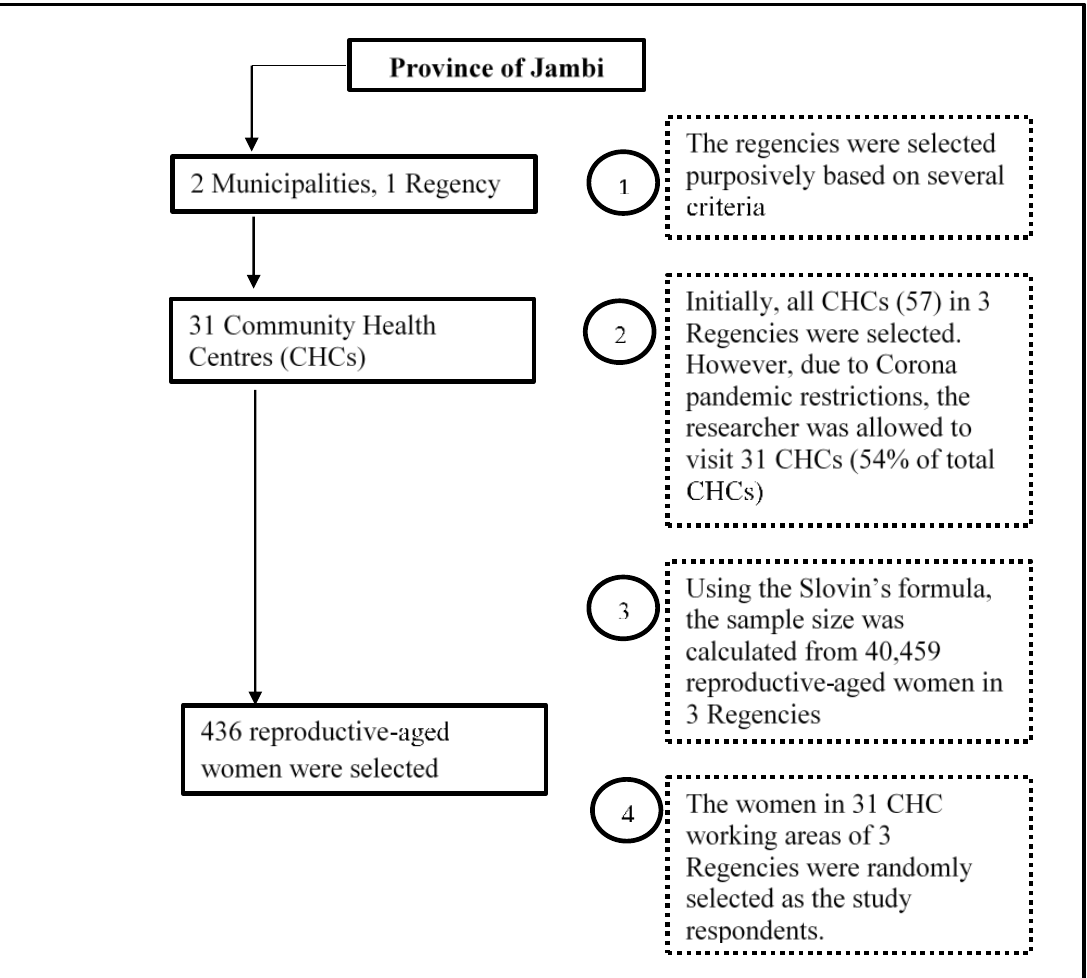
Figure 2. Flow chart of sampling procedures based on this study.